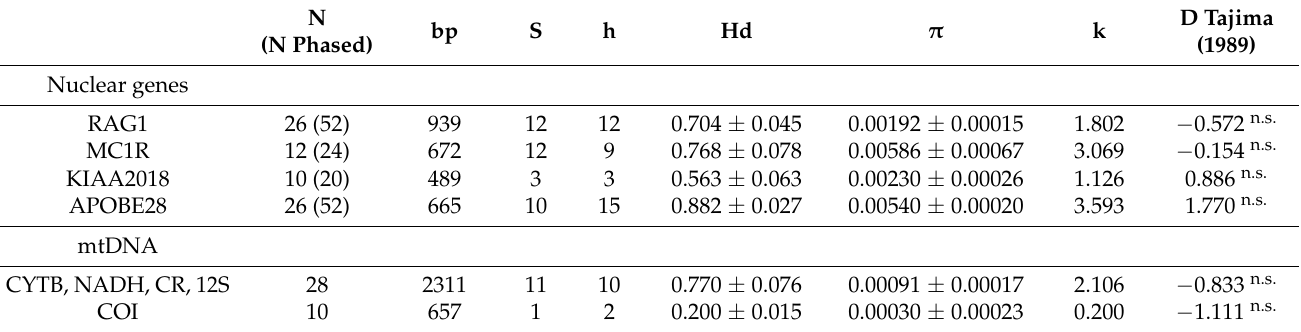
Table 1. Genetic-diversity parameters and neutrality tests for each nuclear gene and for mtDNA align- ment and COI genes from the Columbretes archipelago samples (S, polymorphic positions; h, number of haplotypes; Hd, haplotype diversity; π , nucleotide diversity; k, average nucleotide